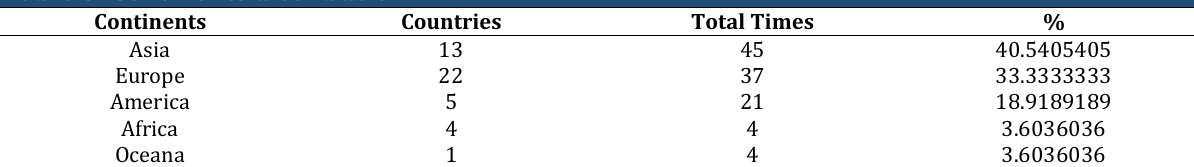
Table 8: Continents distribution